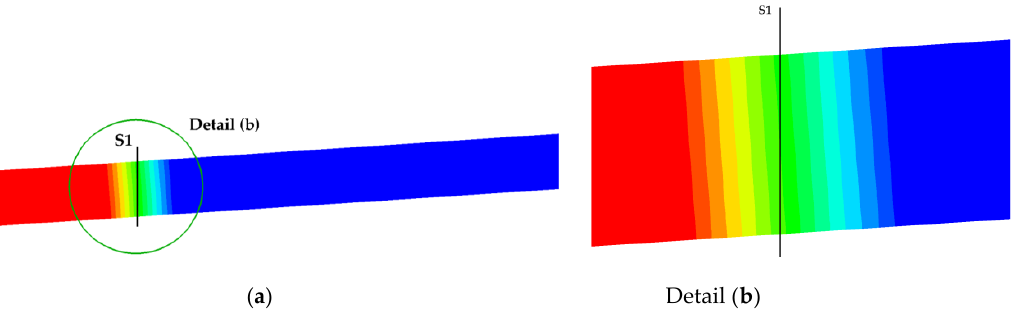
Figure 28. T = 0.08 s Pressure field on the axis plane of the pipeline ( a ) and local pressure distribution around S1 monitoring position ( b ).